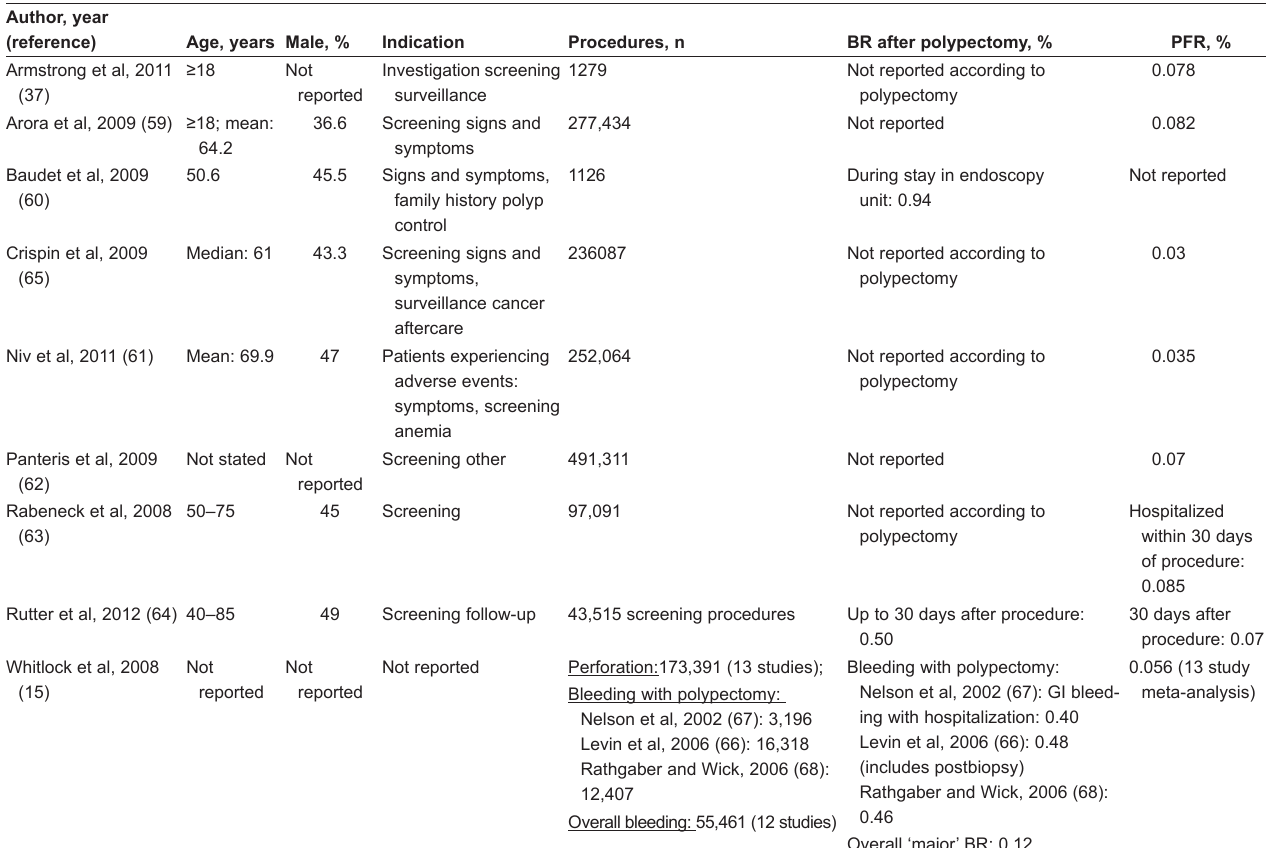
TAble 11 Study outcomes, indicators of colonoscopy safety Author,